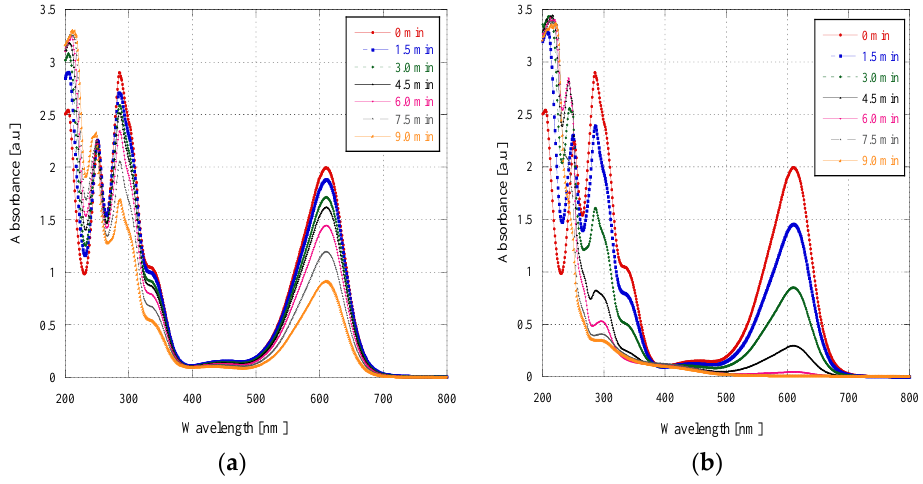
Figure 9. Temporal change of UV-visible spectra of indigo carmine dye solution after 7.5 min at ( a ) 9.1 kV and ( b ) 21.6 kV of applied voltage pulse treatment at water surface.